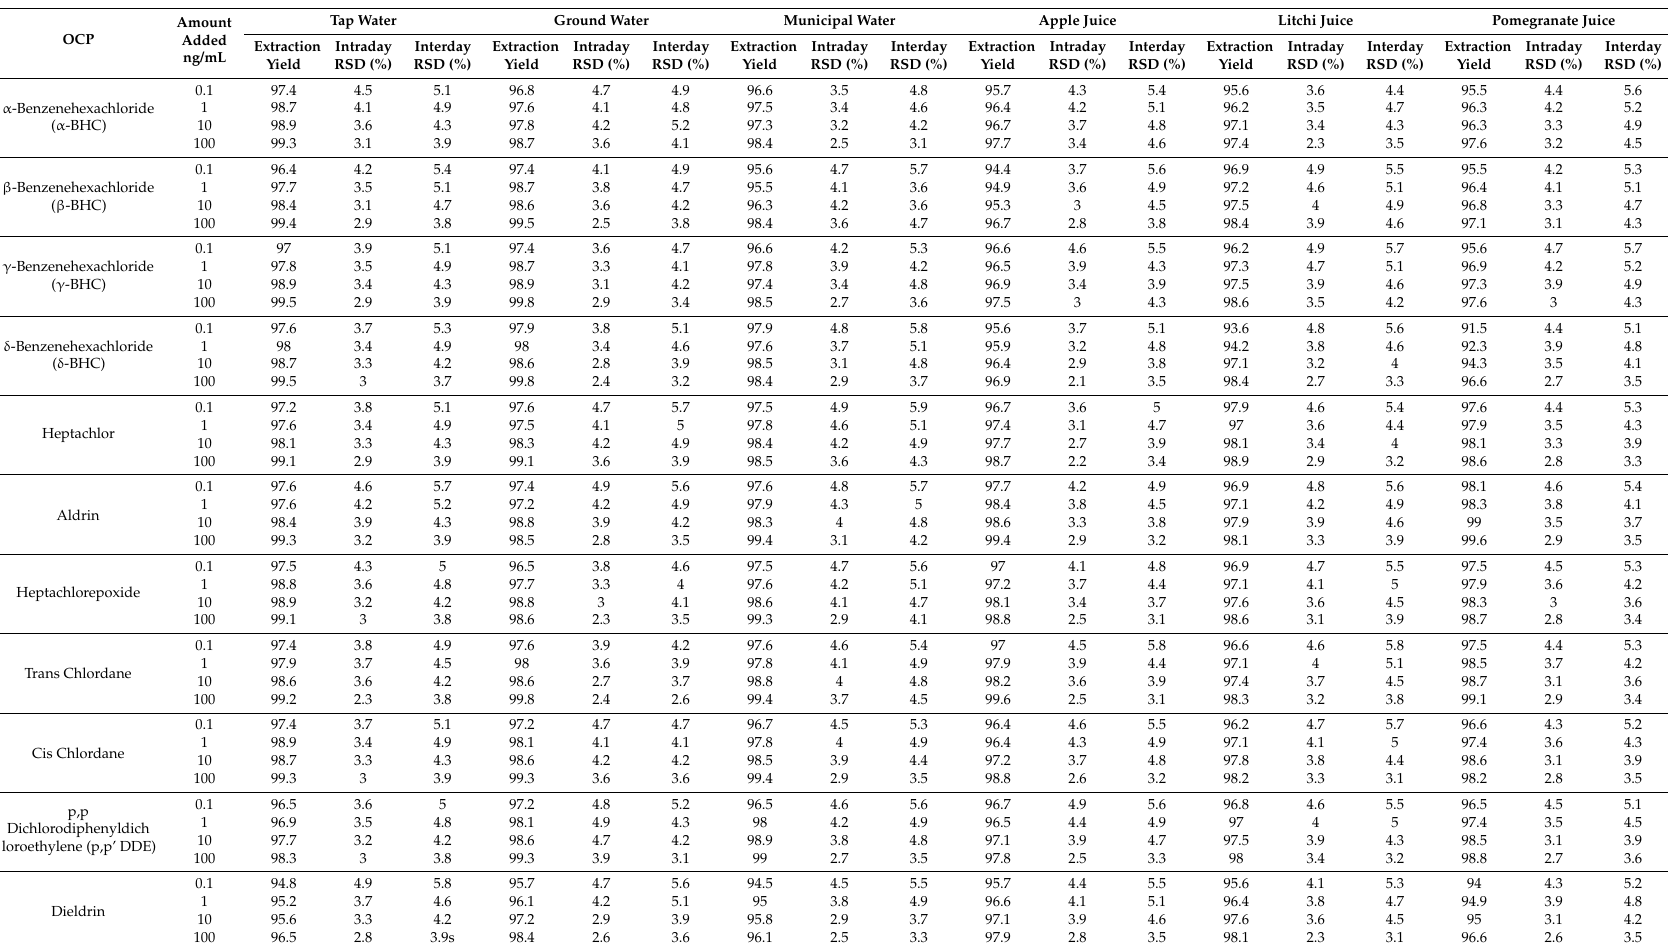
Table 3. Analytical data obtained from FPSE/GC-MS analysis for the determination of OCPs in water and fruit juice